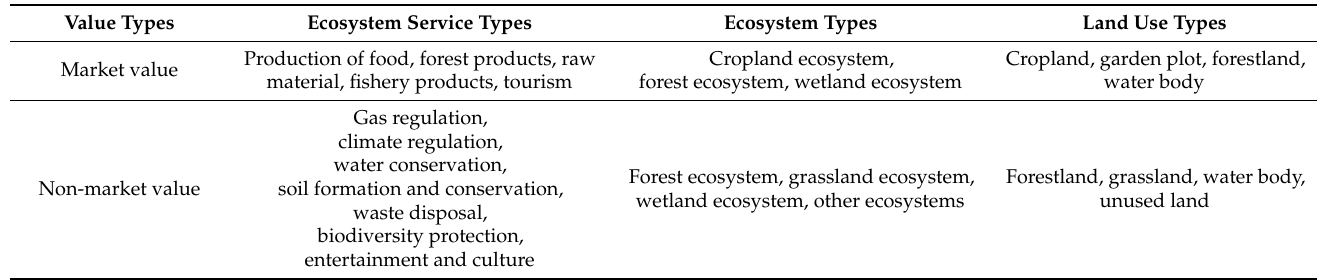
Table 1. Classification of the ecosystem service value in the Poverty Belt around Beijing and Tianjin.